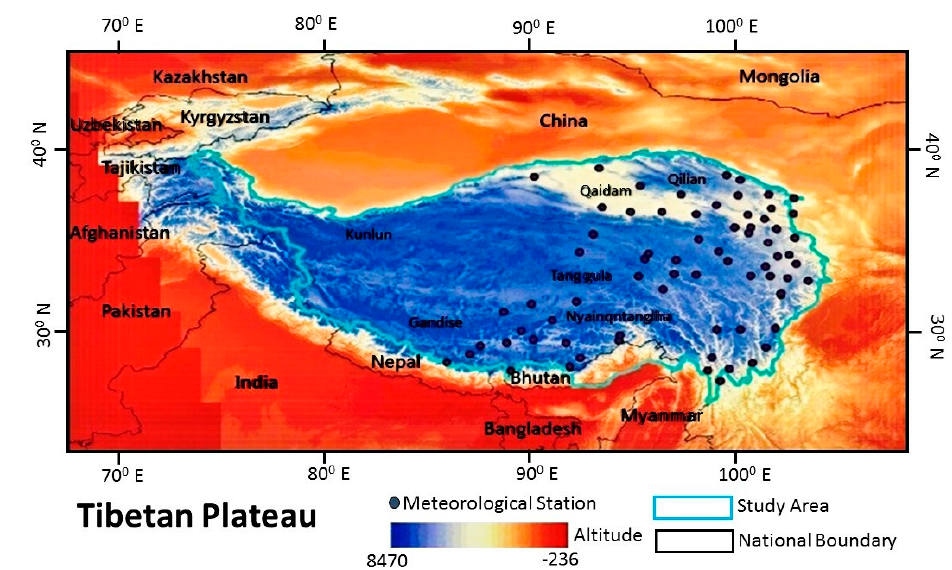
Figure 5. Qinghai–Tibet Plateau of China and the surrounding countries. Location of the monitoring stations is shown (Source: authors).